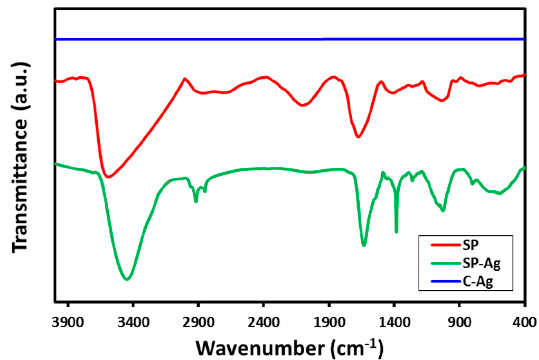
Figure 4. Comparison of the IR spectra of pure S. persica L. RE (SP, red line), Green synthesized Ag-NPs (SP-Ag, green line), and chemically synthesized Ag-NPs (C-Ag, blue line).